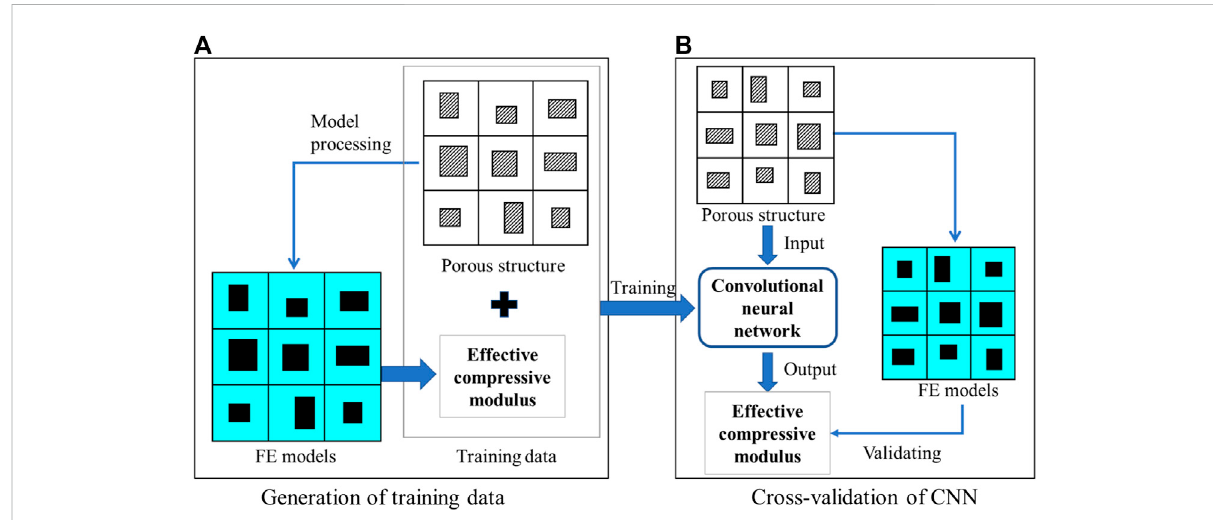
FIGURE 3 The work fl ow for the (A) training and (B) cross-validation of the convolutional neural network (CNN) model.